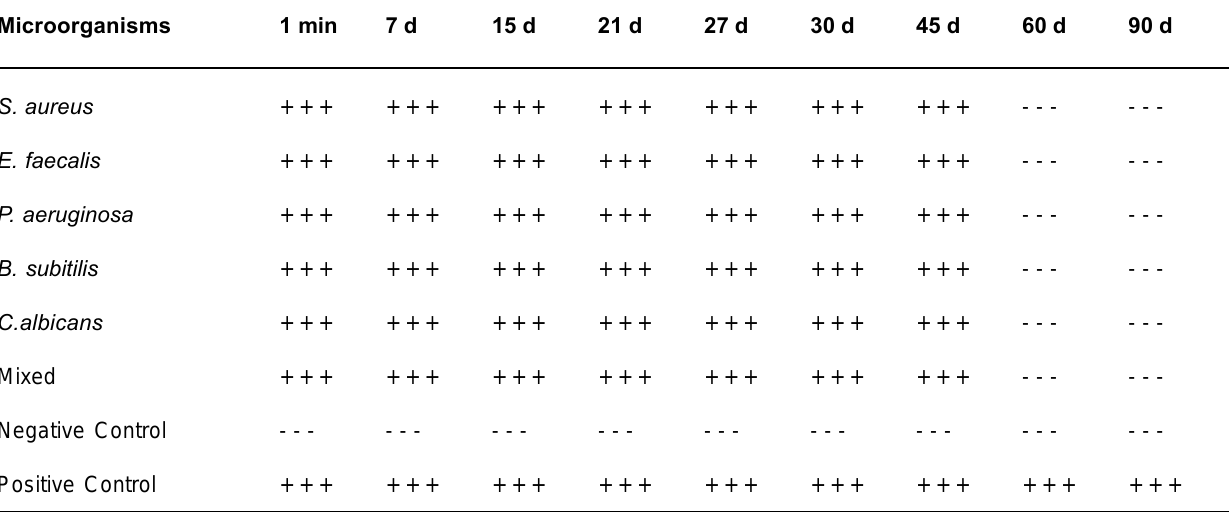
TABLE 1 - Time necessary for CHP paste to eliminate microorganisms in infected canals